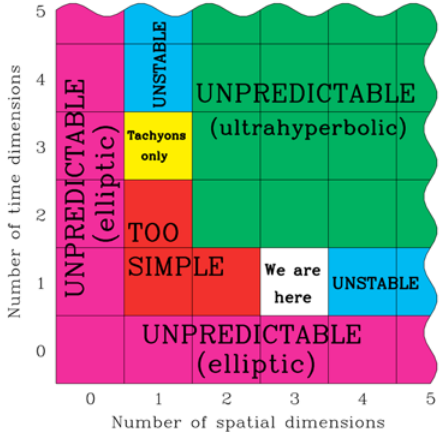
Figure 4. Graphic “On the dimensionality of spacetime”, by Max Tegmark (No implied endorsement of the present work) [23]. Licensed under the Creative Commons Attribution-Share Alike 3.0 Unported